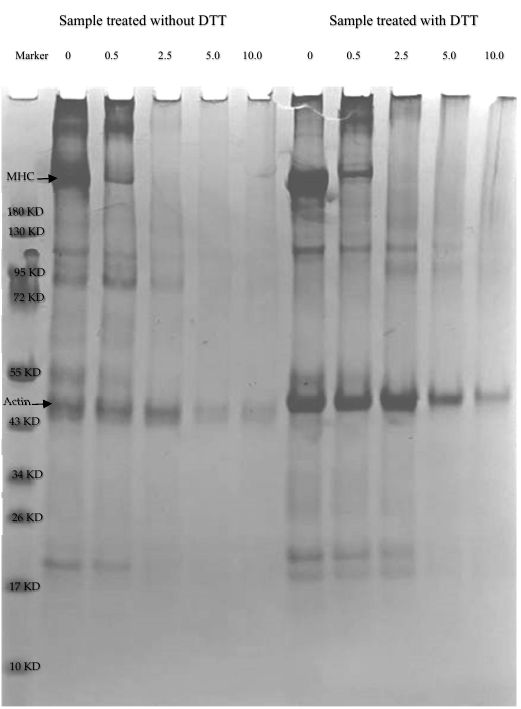
Figure 3. SDS-PAGE pattern changes of duck myofibrillar proteins treated with different malondialdehyde concentrations (0, 0.5, 2.5, 5.0, and 10.0 mmol/L).